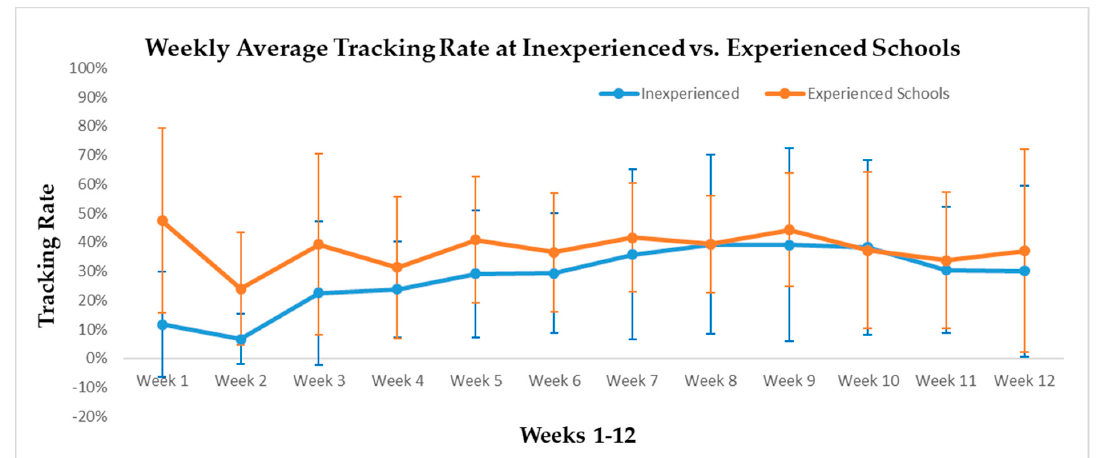
Figure 2. Behavior tracking rate across the 12 Weeks for Inexperienced ( n = 3) and Experienced ( n = 3) Schools. ( n = 3)